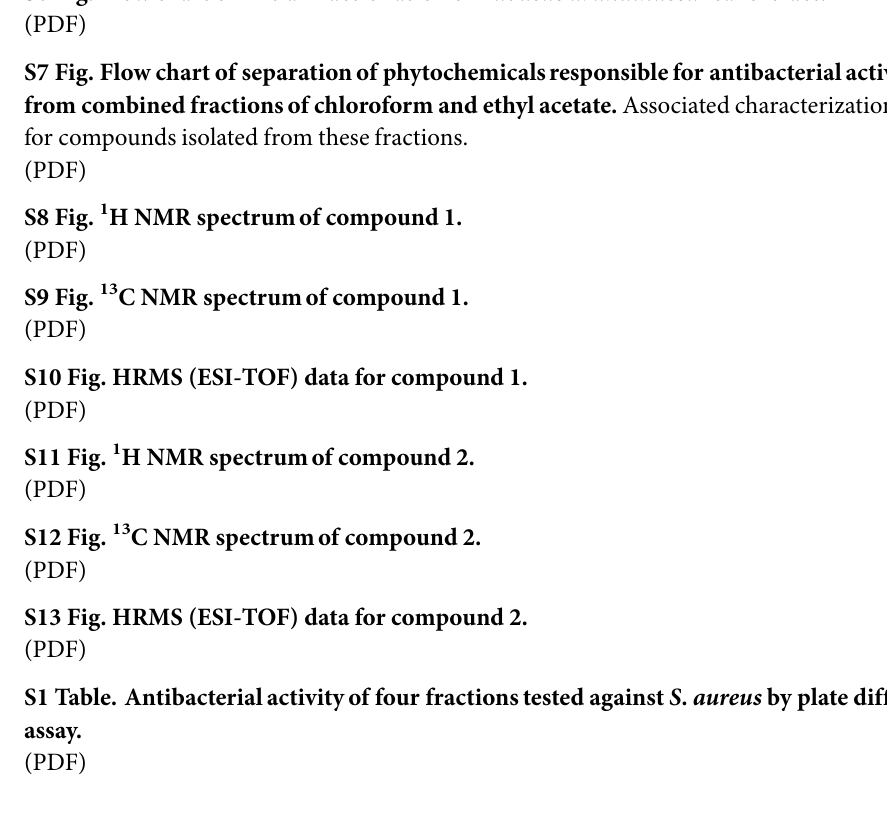
(PDF) (PDF) S1 Table. Antibacterial activity of four fractions tested against S . aureus by plate diffusion assay.